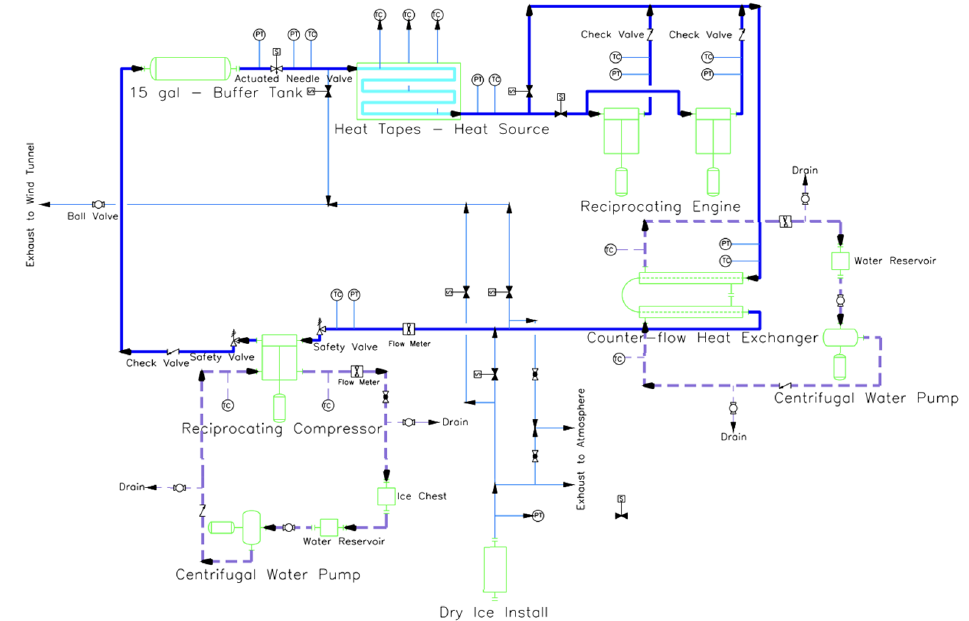
Figure 15. sCO 2 loop P&ID schematic.